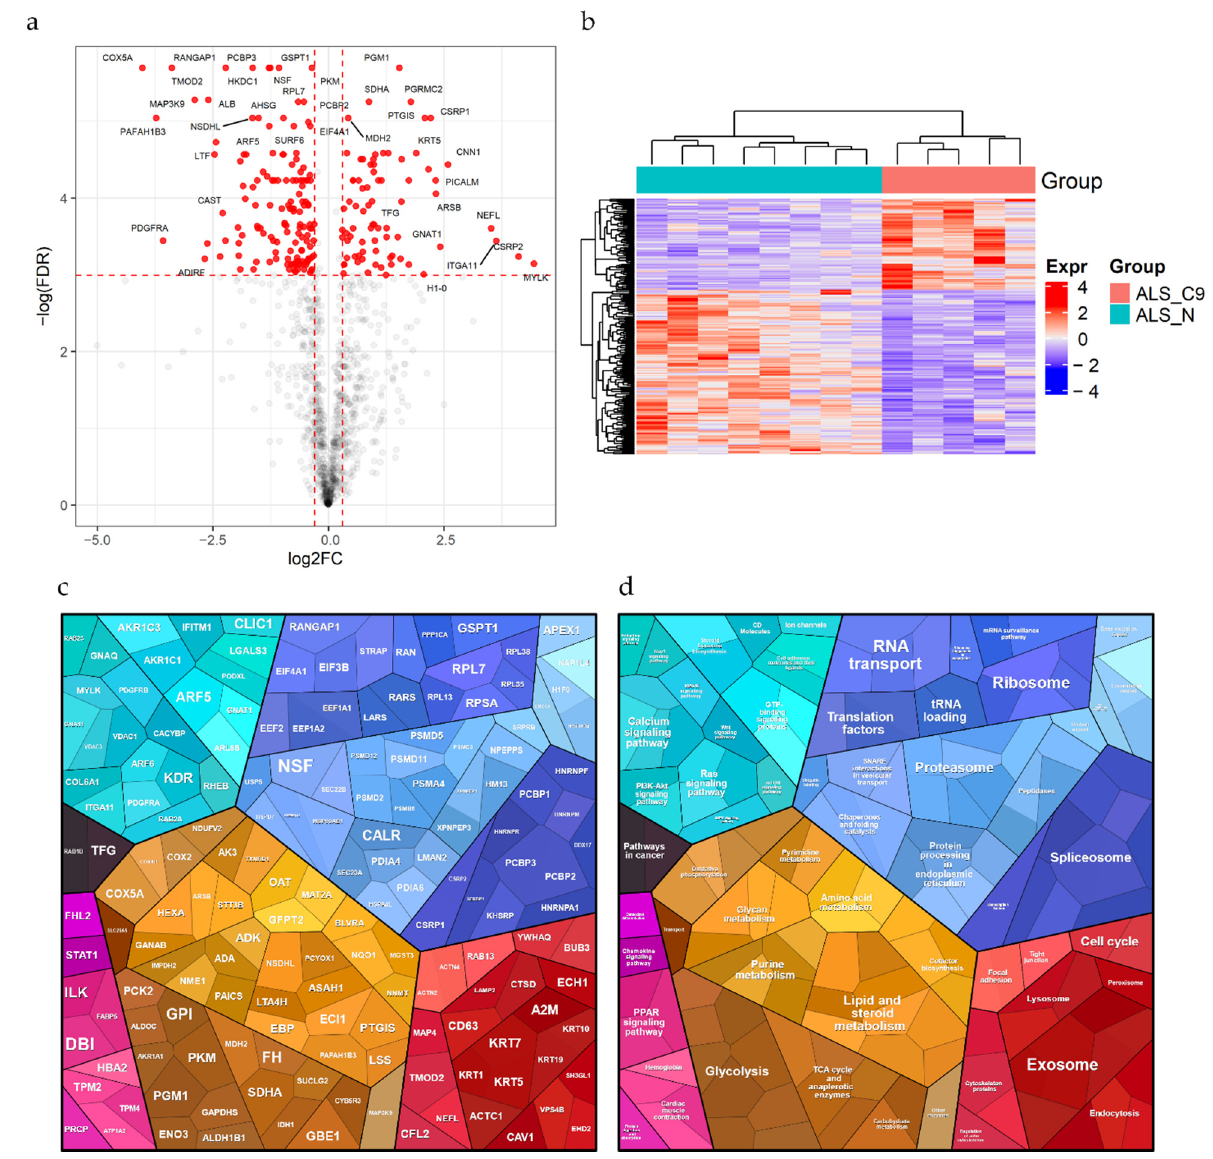
Figure 3. Differential expression analysis (ALS_C9 vs. ALS_N). ( a ) Volcano plot showing all quantified proteins distributed by FC and FDR in log scale (ALS_C9 over ALS_N). Red dashed lines represent thresholds set for significance. Red dots represent differentially expressed proteins ( n = 216). ( b ) Heatmap demonstrating the separation of all patients into two clusters (corresponding to the ALS_C9 and the ALS_N groups) based on the expression levels of the 216 significant proteins (rows). ( c , d ) Voronoi plots showing the differentially expressed proteins grouped and colored by their function. Areas are proportional to the p values. Turquoise: environmental information processing (e.g., calcium signaling pathways, Ras signaling pathway, GTP-binding signaling proteins). Blue: genetic information processing (e.g., RNA transport, ribosome, proteasome, spliceosome). Red: cellular processes (e.g., exosome, cell cycle, endocytosis). Yellow: metabolism (e.g., glycolysis, lipid and steroid metabolism, TCA cycle and anaplerotic enzymes). Pink: signaling (e.g., PPAR signaling pathway). Grey: human diseases (pathways in cancer).